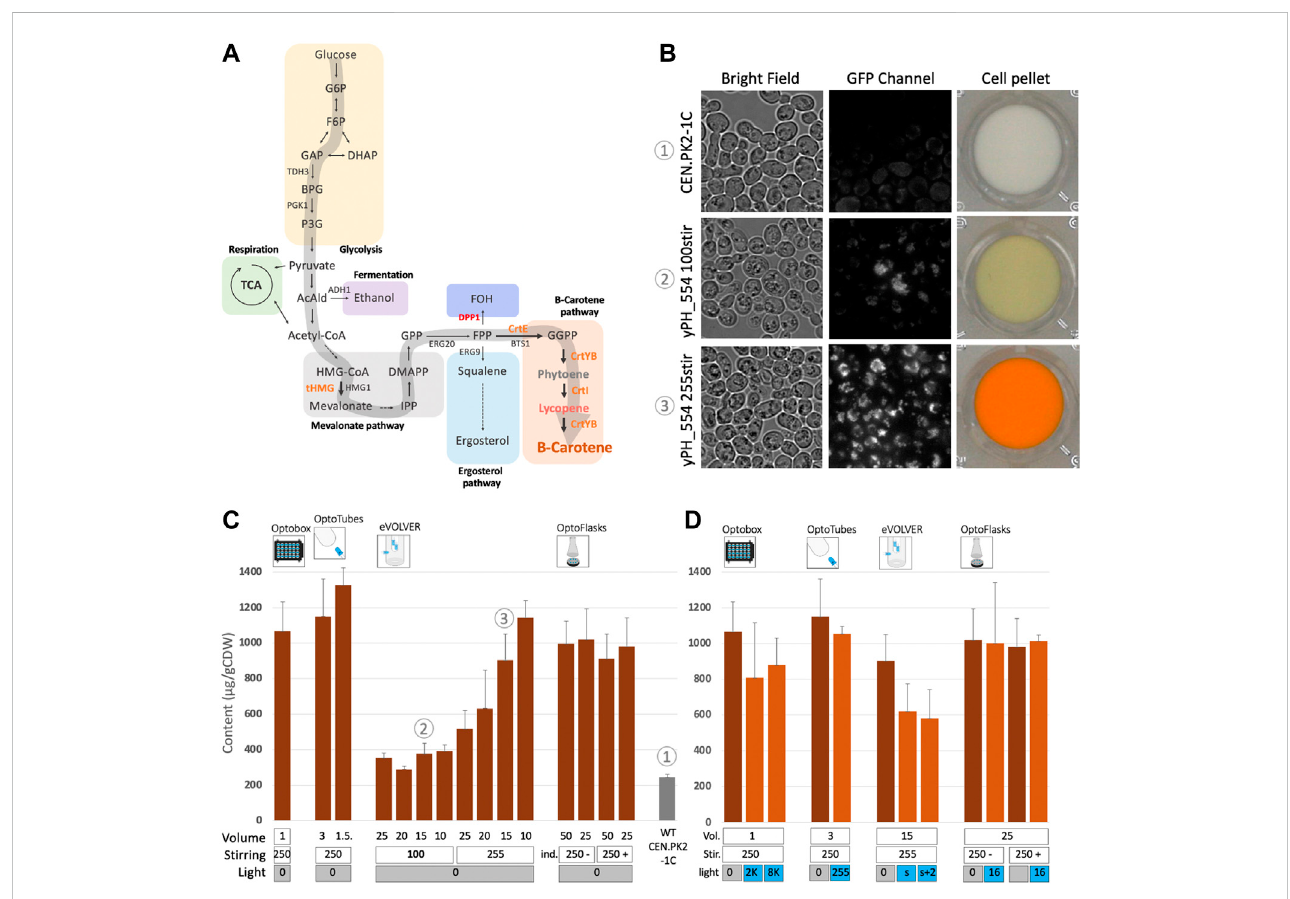
FIGURE 3 Constitutive beta-carotene production and analysis of the effect of light on beta-carotene accumulation in yeast. (A) Beta-carotene pathway. Arrows point to chemical species (see Supplementary Figure S8 for more details), genes names are indicated in capital letters beside arrows. The large grey arrow represents the carbon fl ux leading to beta-caroteneproduction. Orange: heterologous genes inserted under constitutivepromoters.Red: endogenous gene deletion. (B) Microscopic observations and corresponding cell pellets. CEN.PK2-1C (top) strain and constitutive beta-carotene production (yPH_ 554 — middle and bottom). Growth in YPD at 30 ° C for 24 h with low stirring (100 — middle) versus high stirring (255 — bottom). Bright fi eld images and GFP imagesshowingbeta-carotenelocalizedinlipiddropletsandemittingintheGFPchannel(100Xobjective).SeealsoSupplementaryFigureS5. (C) Constitutive beta-caroteneproduction(content — µgbeta-carotene/gcelldryweight)measuredaftergrowthinthedifferentdevices(seeMethods).Volume(mL),stirring/ shaking (rpm except for eVOLVER, which is given in arbitrary units, + and - in OptoFlasks represent the presence or absence of indentation, respectively). In this panel, all experiments were performed in the dark (non-optogenetic strain). The WT non-producer strain is CEN.PK2-1C. Sample numbers indicated in circled numbersin (C) matchimages in (B) . (D) Effect oflighton constitutivebeta-caroteneproduction inthedifferentdevices. Dark-orange barsare cultures keptinthedark,light-orangebarsareilluminated cultures.Volume(mL),stirring(rpm oru.a. andindentation presence)arethesameasin (C) andlight(u.a.)as in Supplementary Figure